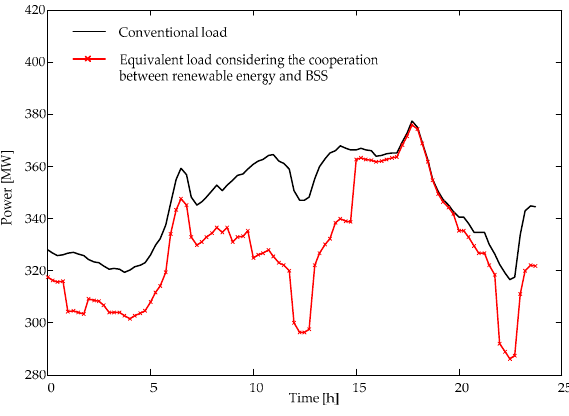
Figure 9. The load curve with different pricing strategy.